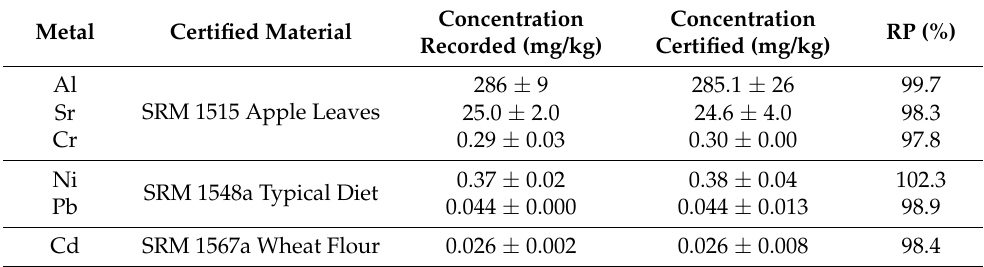
Table 3. Recovery study results based on the recovery percentage (RP) with reference